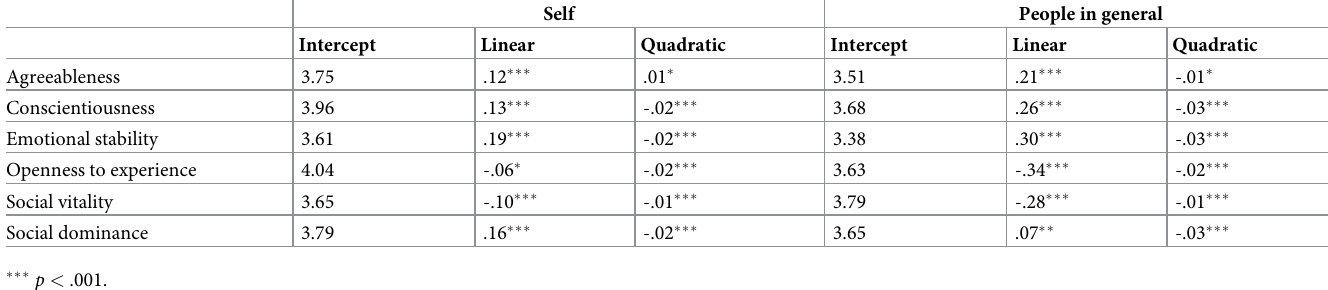
Table 3. Linear and quadratic trends of perceived changes in personality for the Self and people in